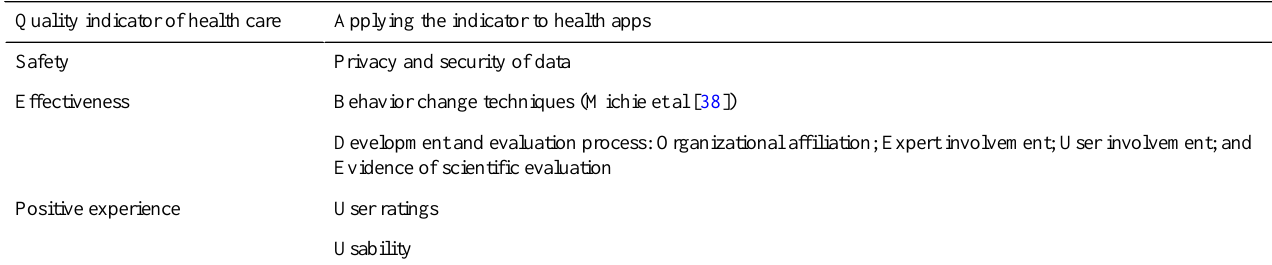
Table 1. The application of the health care quality indicators to physical activity apps. Applying the indicator to health appsQuality indicator of health